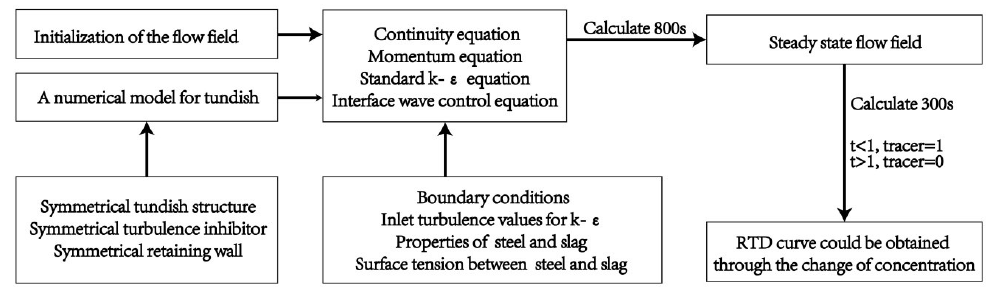
Figure 3. The details of the numerical simulation process.